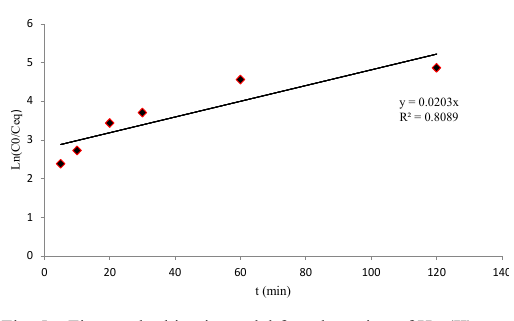
Fig. 5. First- order kinetic model for adsorption of Hg (II) Fig.5: First-orderkineticmodelforadsorptionofHg(II)ontoFe 3 O 4 –Polyrhodanineat25 ◦ C onto Fe3O4 –Polyrhodanine at 25 ◦C